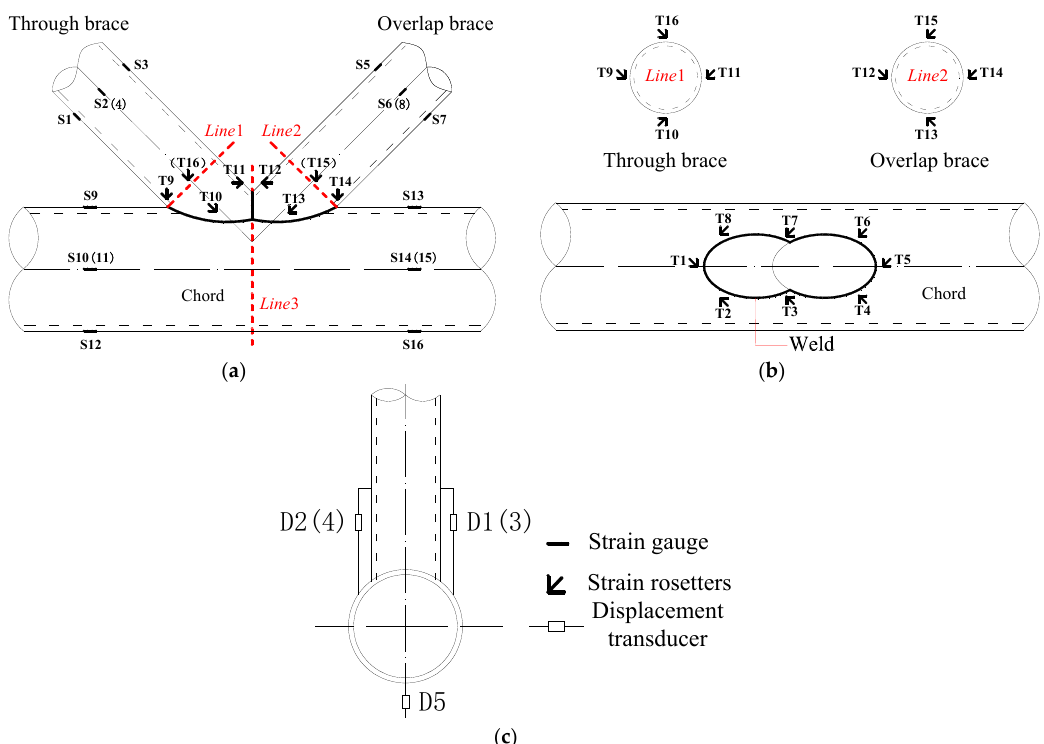
Figure 5. Layout of measuring points. ( a ) Front view of the K-joint; ( b ) top view of the K-joint; ( c )the side view of the K-joint.